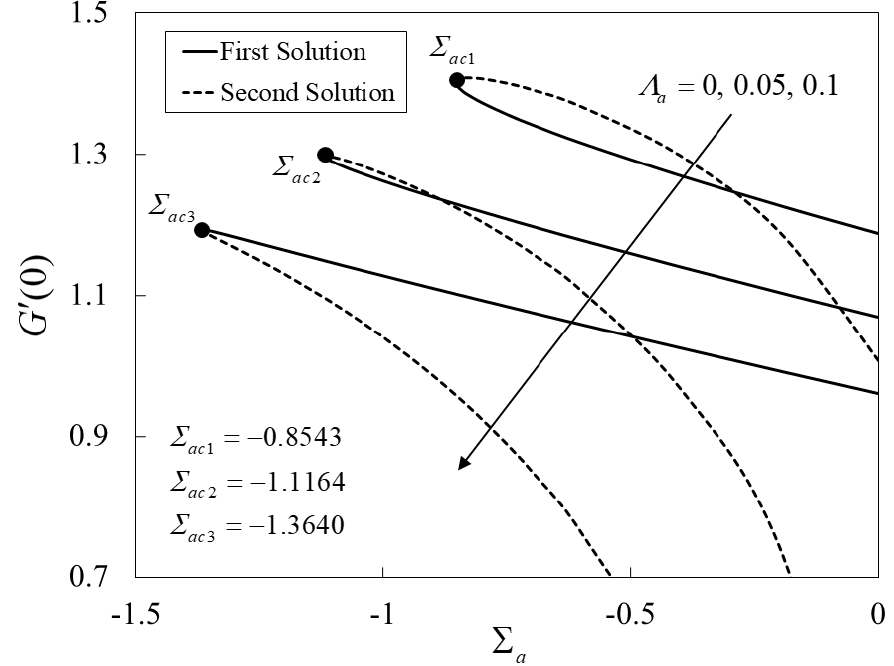
Figure 3. Variation in the local Nusselt number G (cid:48) ( 0 ) with Σ a for different values of Λ a .